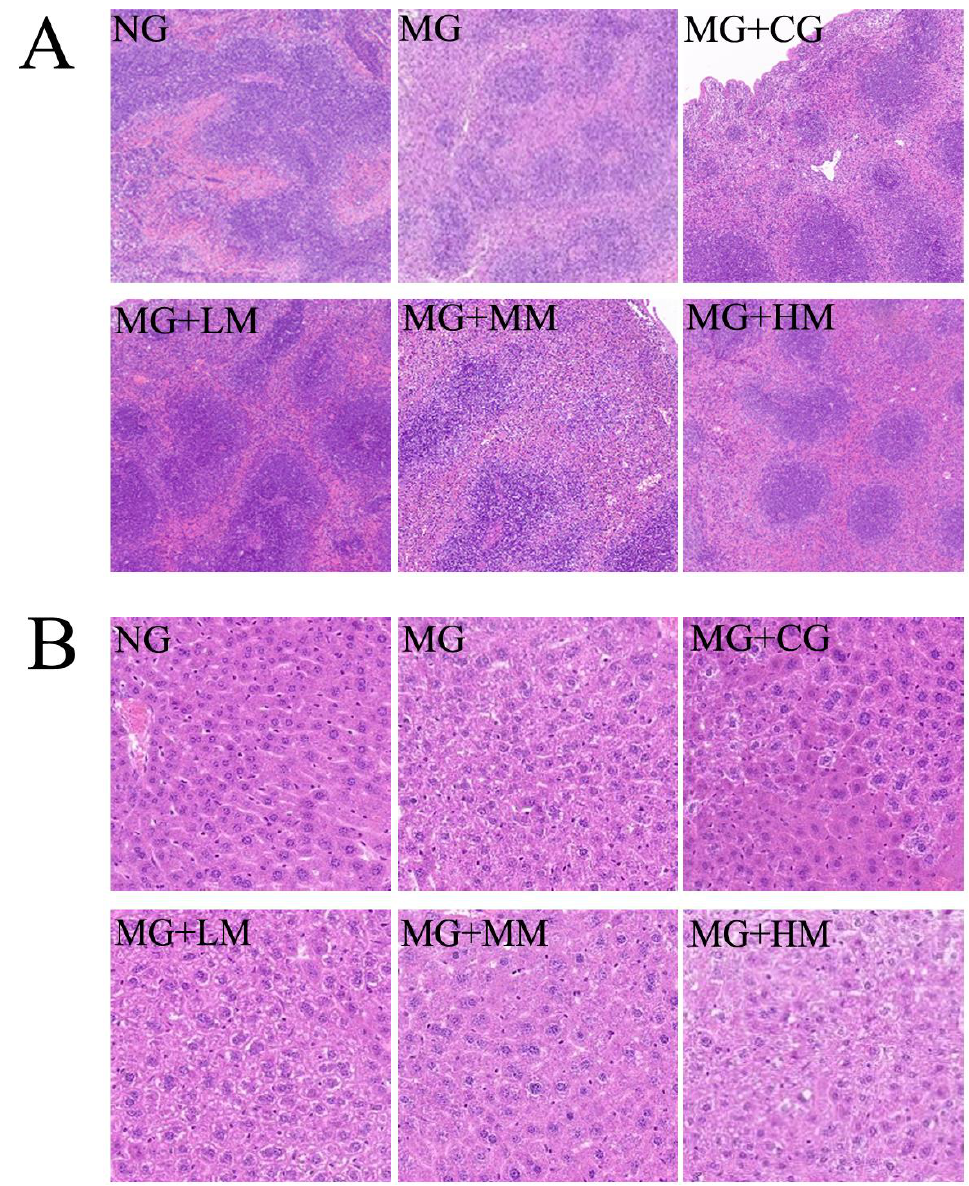
Figure 4. Effect of MRJPs on H&E staining of the spleen and liver. ( A ) Histological observations of spleen and ( B ) histological observations of liver.